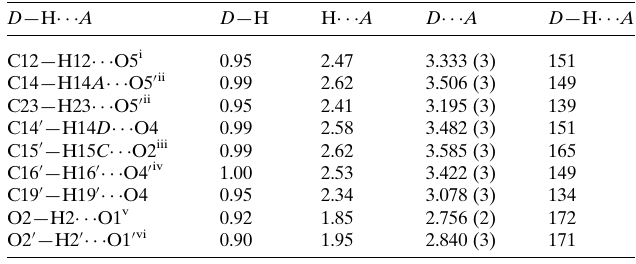
Table 1 Hydrogen-bond geometry (A˚ , (cid:2) ).